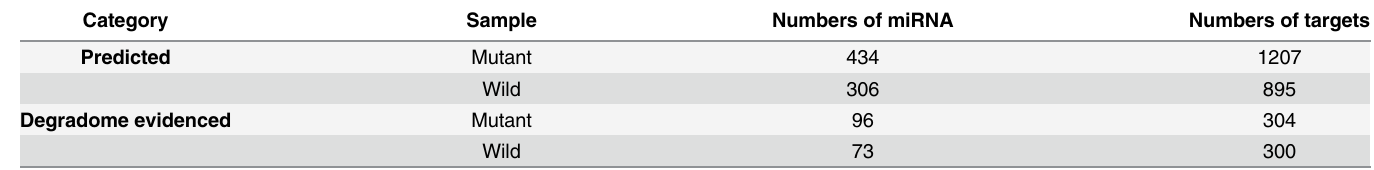
novel miRNAs were differentially expressed in mutant and wild-type libraries based on the wild/mutant)| > 1 between mutant and wild-type strains selection criteria of |fold-change (log 2 (S4 Table). Degradome sequencing results showed that four and eight predicted novel miRNAs were upregulated and down-regulated, respectively (Table 8). miRNA expression analysis results revealed that miRNAs could be implicated in wheat growth and development. on the basis of transcriptome sequencing and degradome sequencing results (Table 8 and S5 Table). Real-time PCR was performed to validate the presence of these miRNAs (S1 Fig). Among these miRNAs, miR1151 and miR5493 had very high CG content in their gene sequences to synthesize the primer; thus, these miRNAs were excluded from real-time PCR. Table 7. Statistics of miRNA